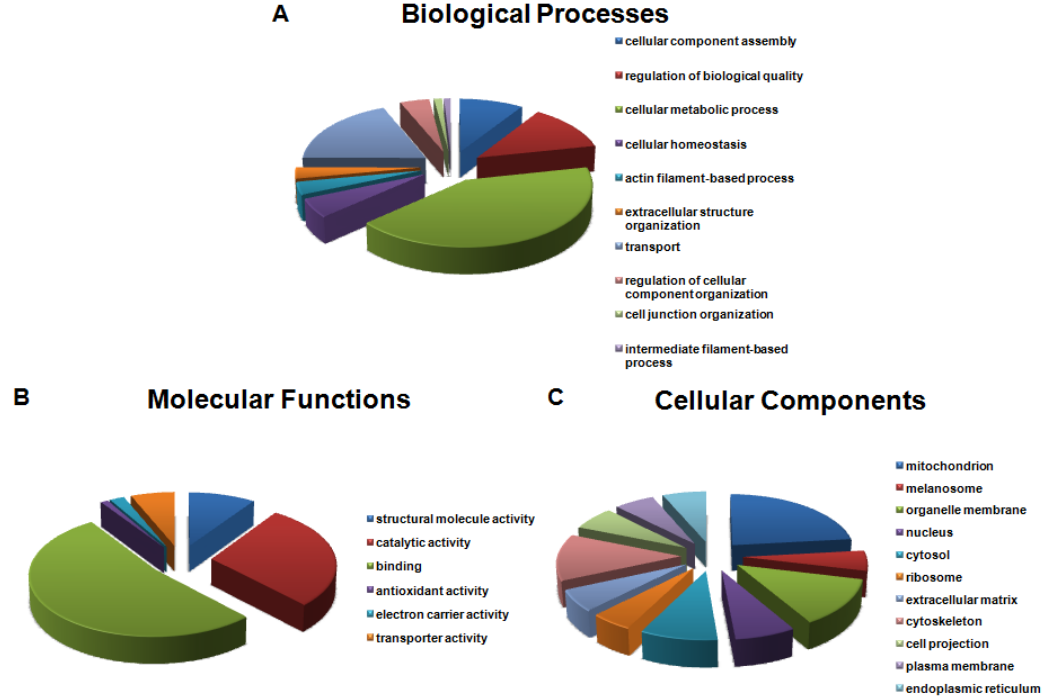
Figure 4. Gene Ontology (GO) analysis of the OC proteome with The Database